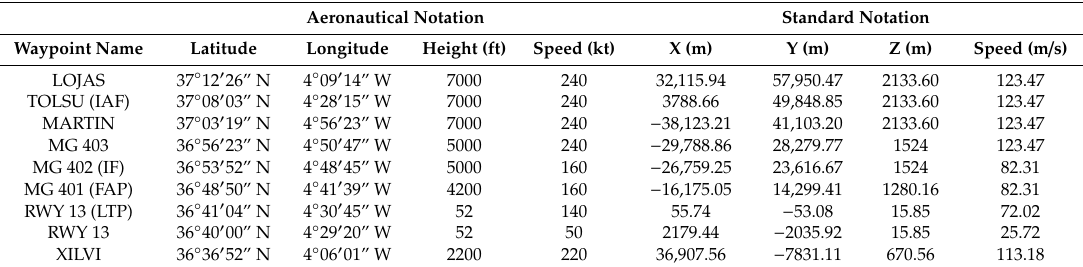
Table 3. Detail of the approach procedure.